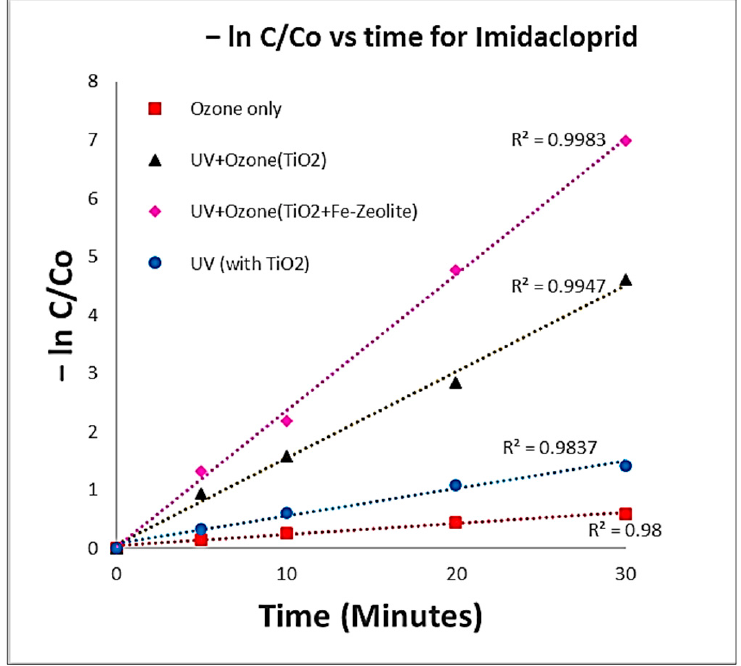
Figure 7. Kinetics of imidacloprid degradation by various AOPs. The dotted line represents the model fitting.